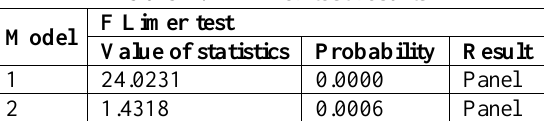
Table 2: F Limer test results